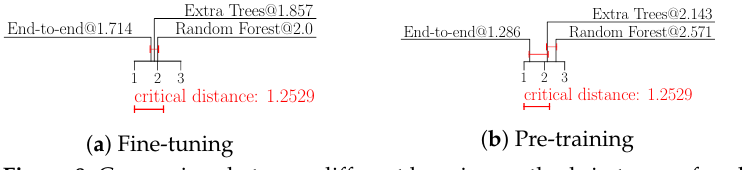
Figure 8. Comparison between different learning methods in terms of ranking loss. The results are presented in the form of average rank diagrams at 0.05 significance level for ( a ) Fine-tuning and ( b ) Pre-training only. The best ranking methods are at the left-most side of the diagram. The differences among the methods connected with a red line is not statistically